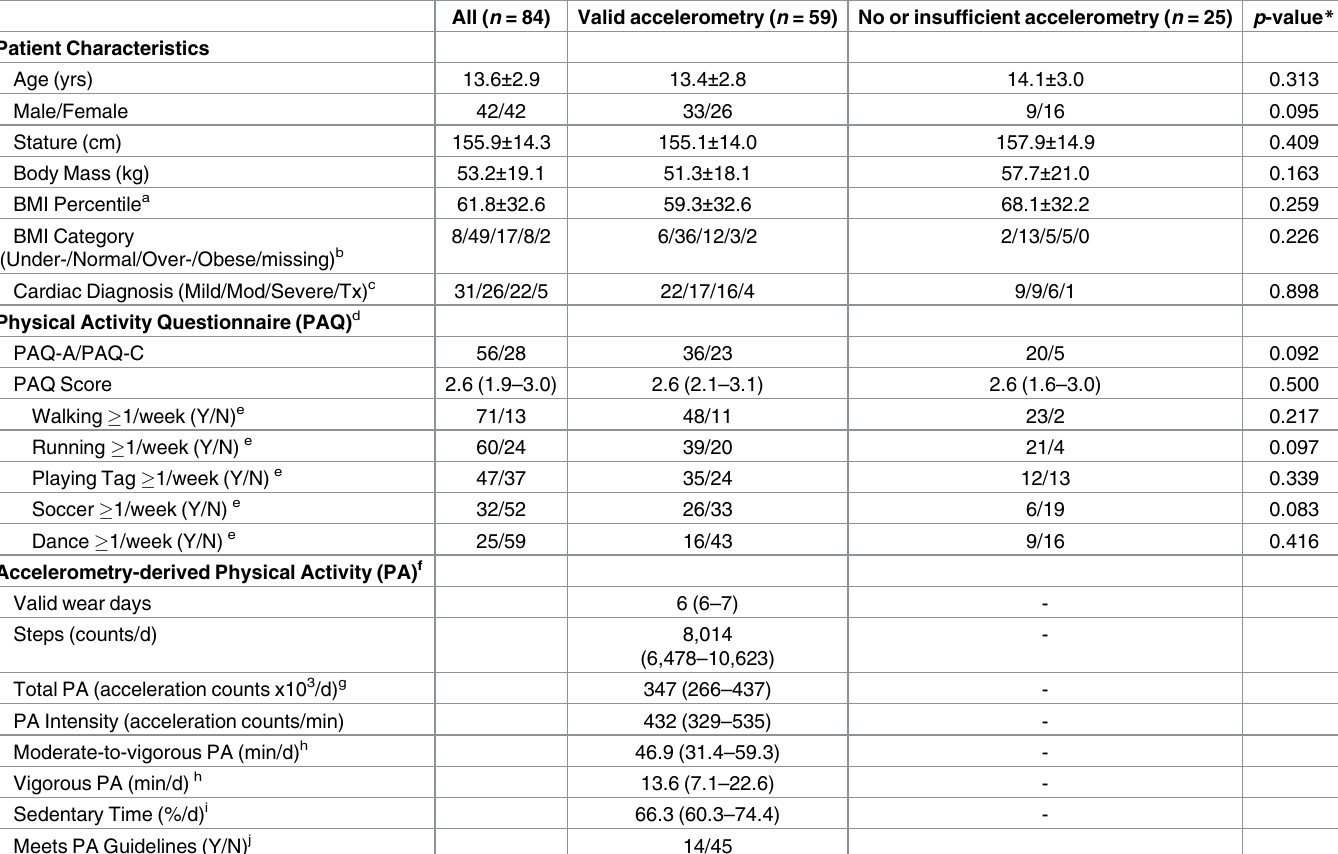
Table 1. Sample characteristics and physical activity levels, stratified by availability of valid accelerometry